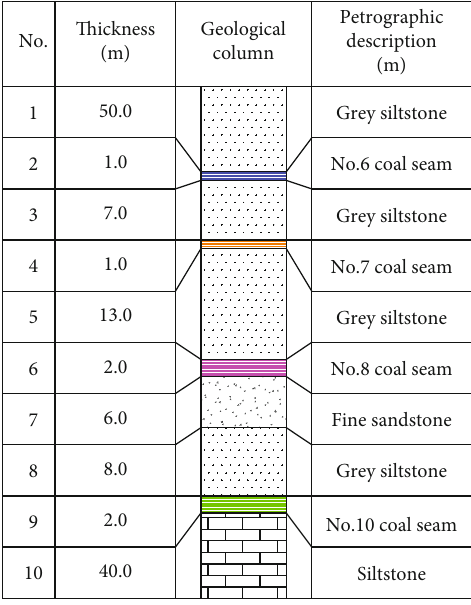
Figure 2: Coal seam comprehensive